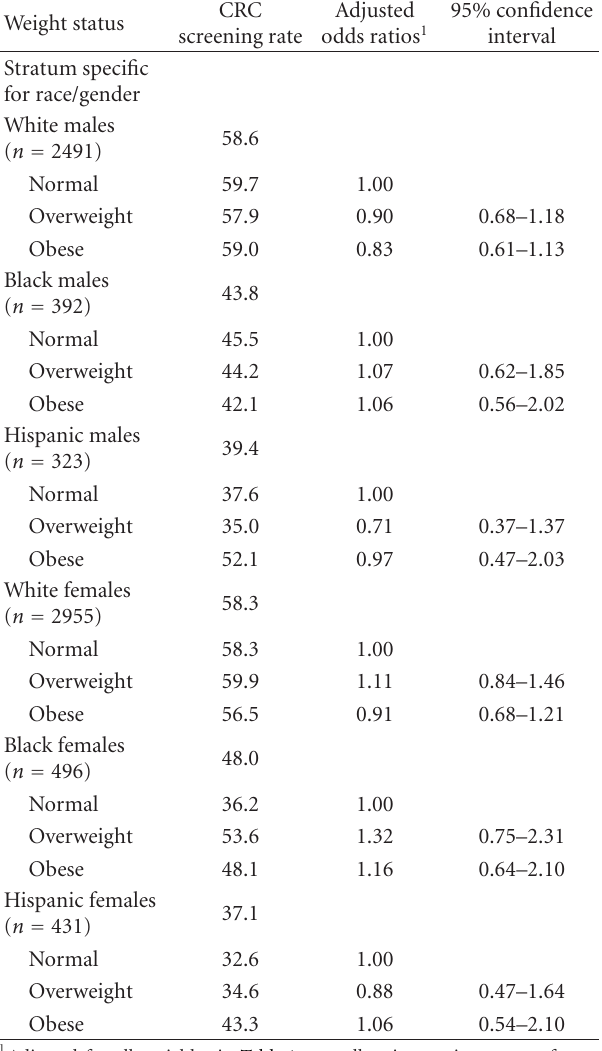
Table 2: Adjusted model for colorectal cancer screening according to race/gender and ethnicity ( n =